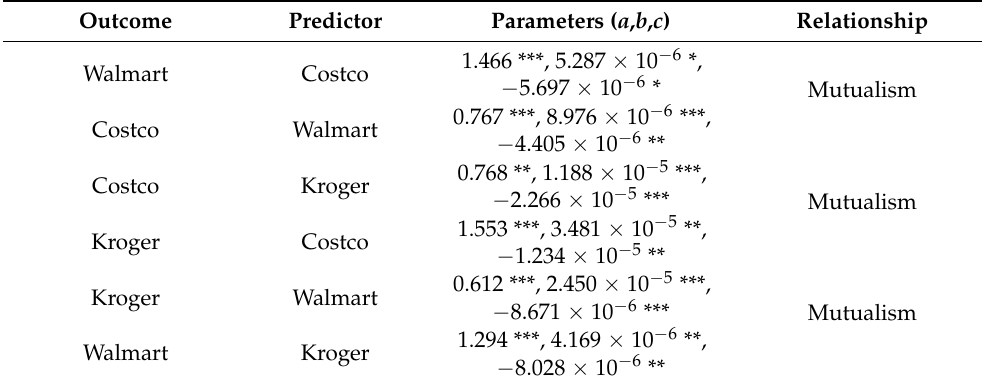
Table 6. Pairwise analyses for the three retail firms.